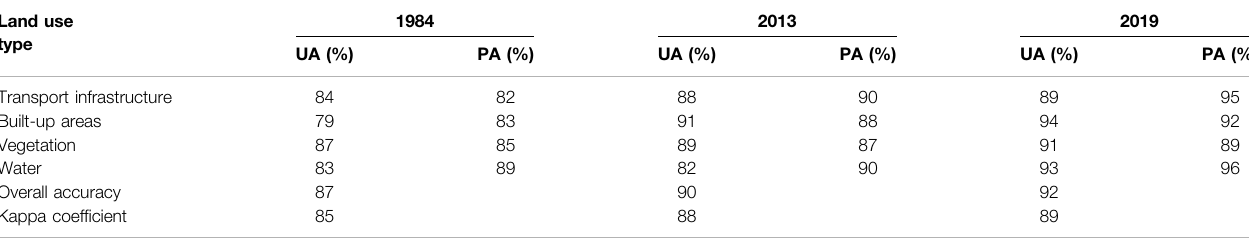
TABLE 3 | LULC maps for accuracy assessment.